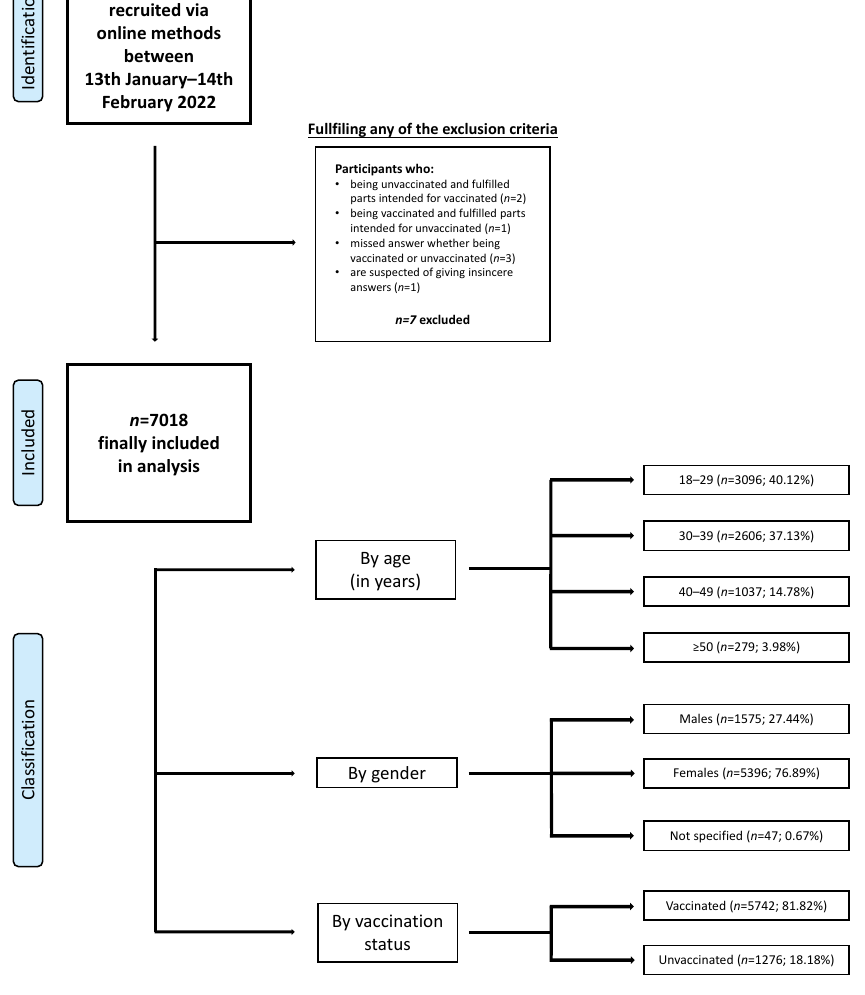
Figure 1. Data selection